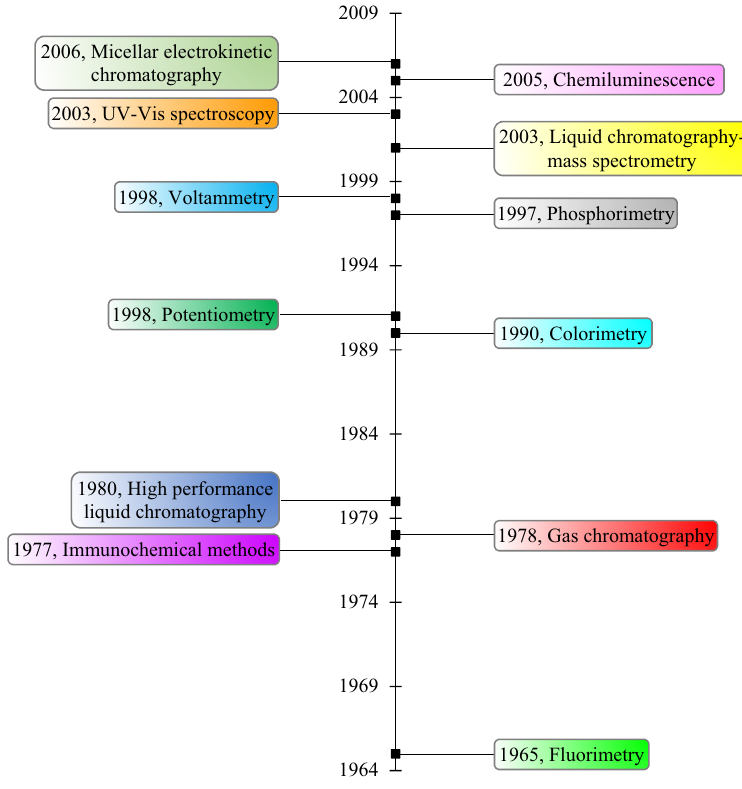
Figure 3: Chronological overview of the beginnings of development of methods for INDO